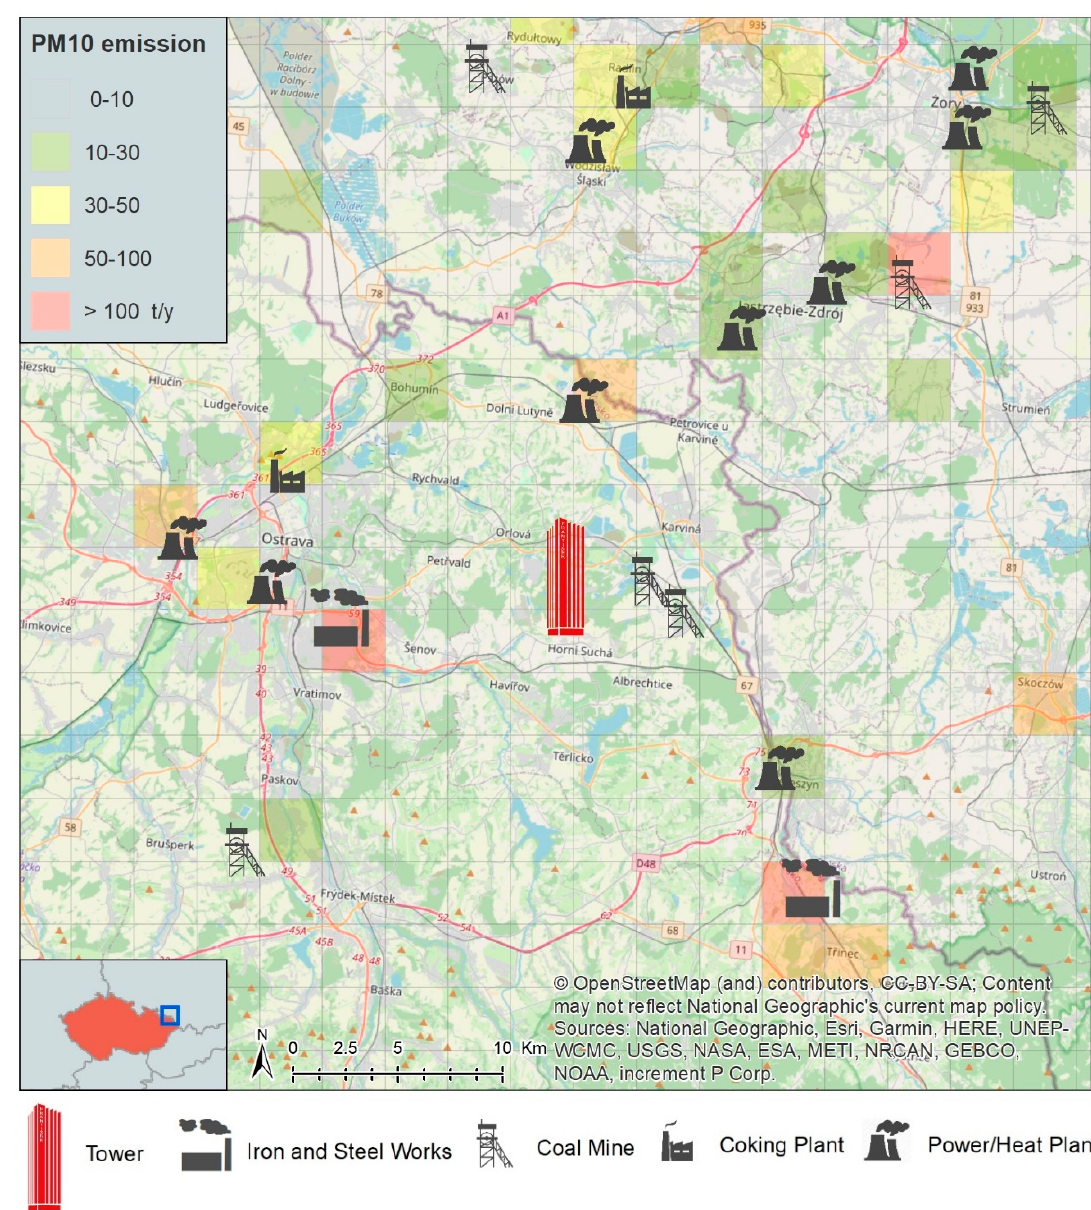
Figure 1. The location of the tower at a regional scale with plotted industrial PM 10 emissions.